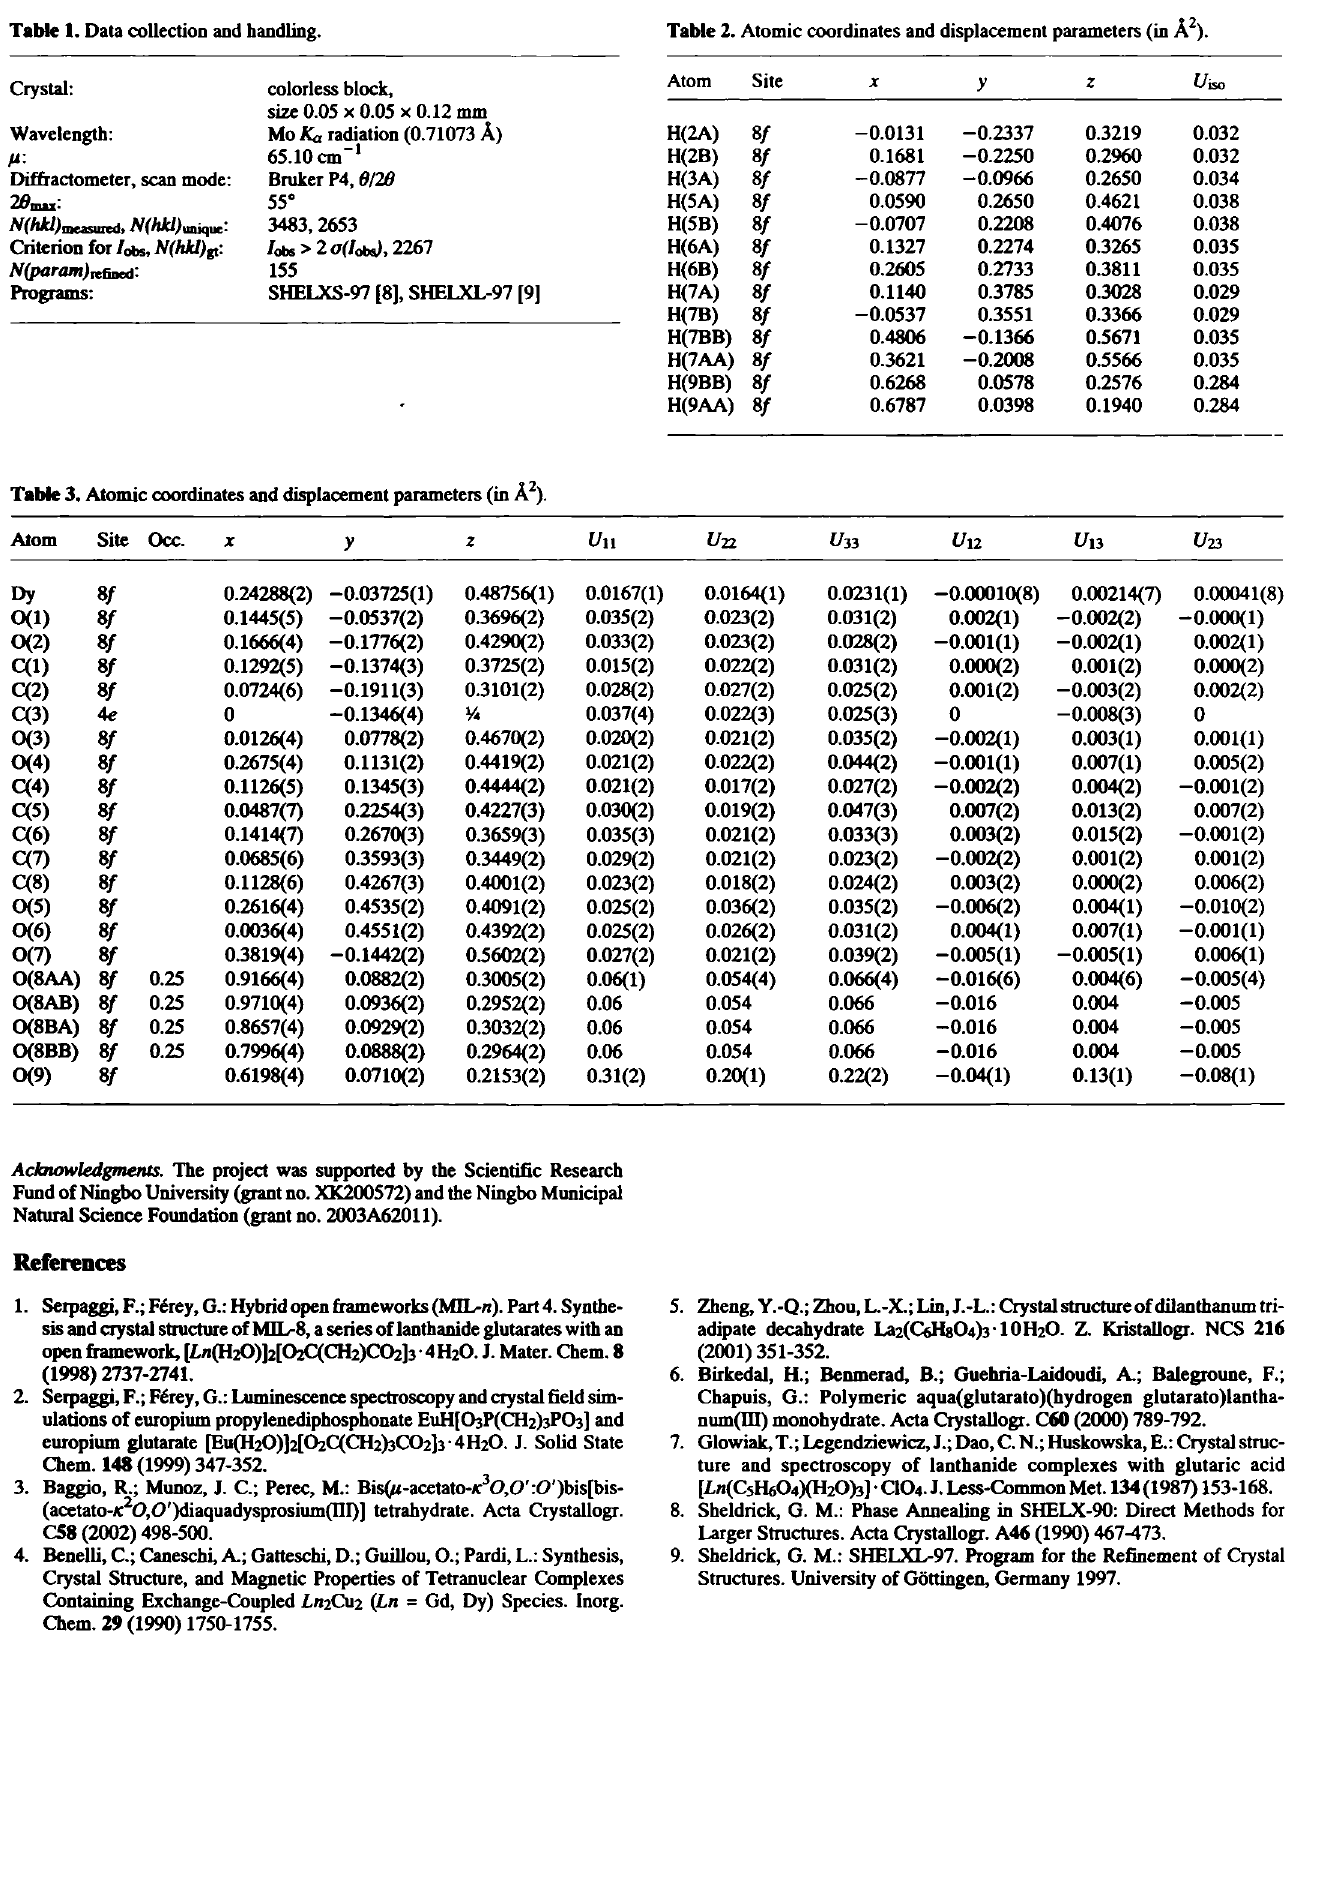
Table 3. Atomic coordinates and displacement parameters (in A 2